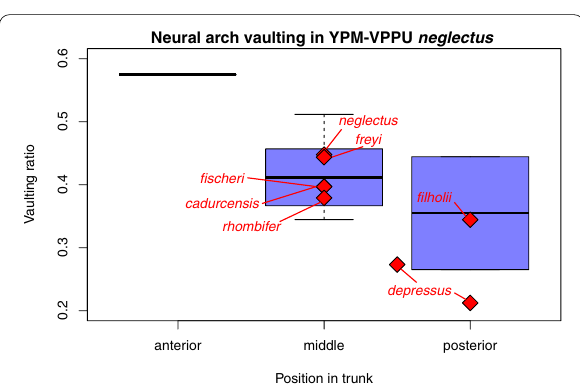
Fig. 43 Vaulting ratio in anterior, mid- and posterior trunk vertebrae in the YPM sample of “ Palaeopython ” neglectus compared to same ratio in type material of various Paleogene constrictors from Europe. Only two posterior trunk vertebrae of “ Palaeopython ” neglectus are known, and they show very different vaulting ratios, one of which falls in the distribution of Phosphoroboa filholii comb. nov. Without a larger sample, the significance of this is unknown. Two types are plotted for Paleryx depressus (junior synonym of Paleryx rhombifer ) because one vertebra is close to the mid-/posterior trunk boundary, and moving it to the one or the other column would be